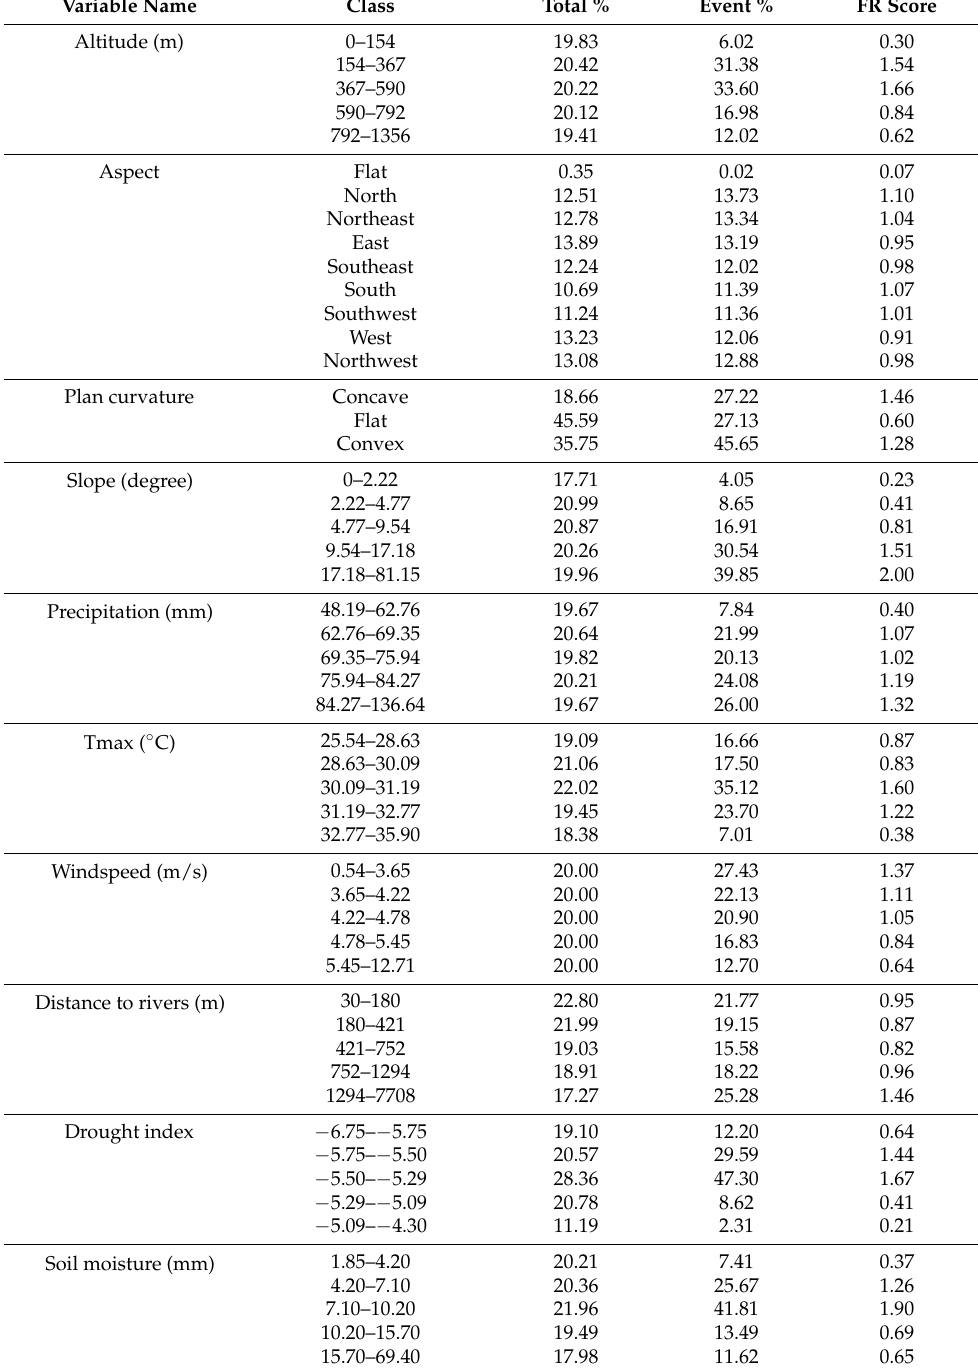
Table 4. Frequency ratio